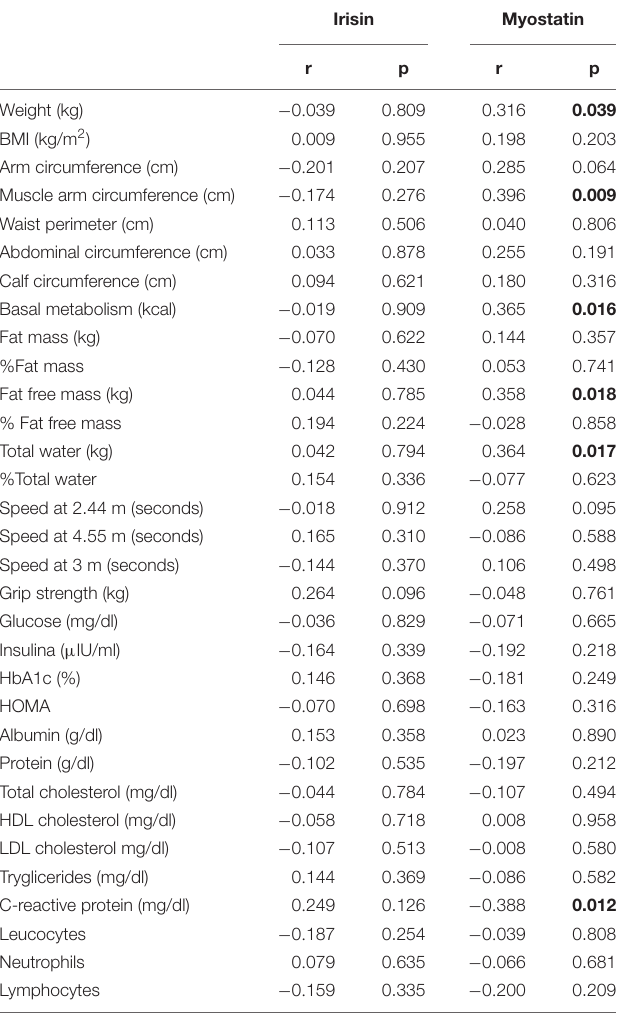
TABLE 5 | Bivariate correlations between anthropometrical and clinical parameters and circulating irisin and myostatin in all participants at baseline. Irisin